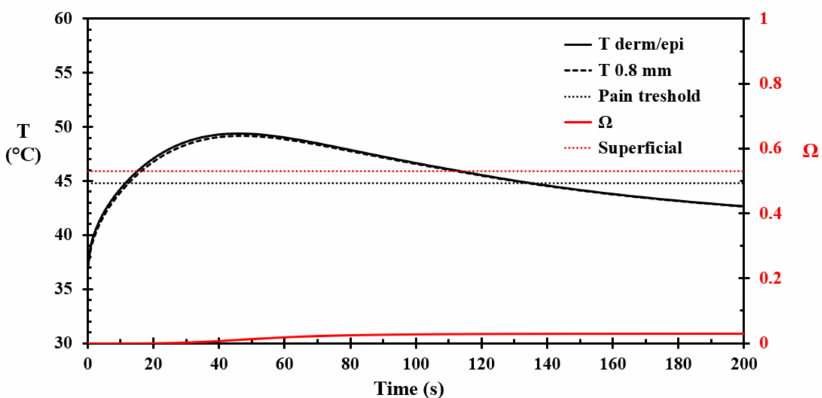
Figure 7. The basal layer and 0.8 mm depth skin temperature, and the corresponding damage integral development, versus time for Case 2.